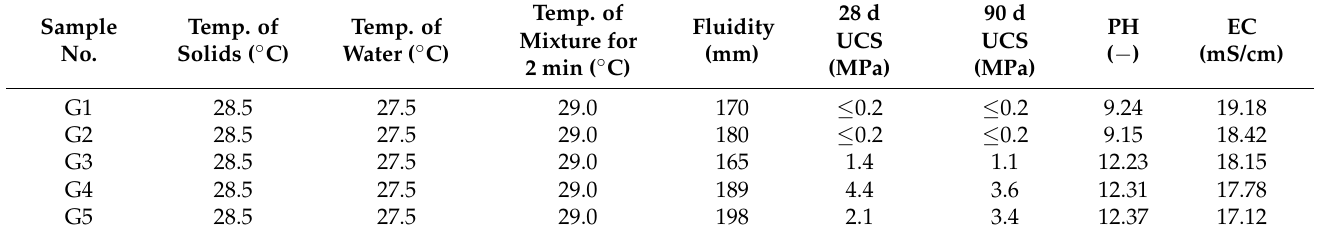
Figure 1. The hardening observation of paste (G5) and controls (G1, G2, G3, and G4) at the curing age of 7 days. Table 4. The measured physical and chemical performances of pastes (G5) and controls (G1, G2, G3, and